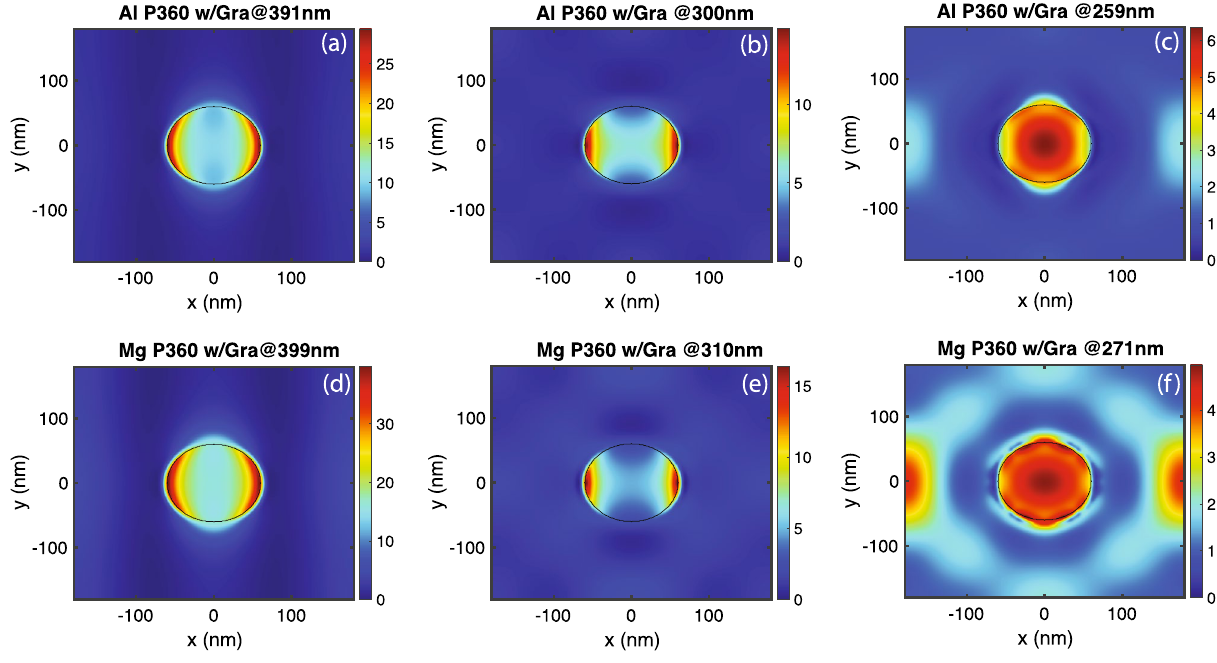
Figure 7. In-plane components of the electric field in graphene at multiple absorption peak positions. ( a ) | E l | 2 in a monolayer of graphene on an aluminum hole-array with periodicity 360 nm at (cid:31) = 391 nm. ( b ) | E l | 2 in a monolayer of graphene on an aluminum hole-array with periodicity 360 nm at (cid:31) = 300 nm. ( c ) | E l | 2 in a monolayer of graphene on an aluminum hole-array with periodicity 360 nm at (cid:31) = 259 nm. ( d ) | E l | 2 in a monolayer of graphene on a magnesium hole-array with periodicity 360 nm at (cid:31) = 399 nm. ( e ) | E l | 2 in a monolayer of graphene on a magnesium hole-array with periodicity 360 nm at (cid:31) =310 nm. ( f ) | E l | monolayer of graphene on a magnesium hole-array with periodicity 360 nm at (cid:31) = 271